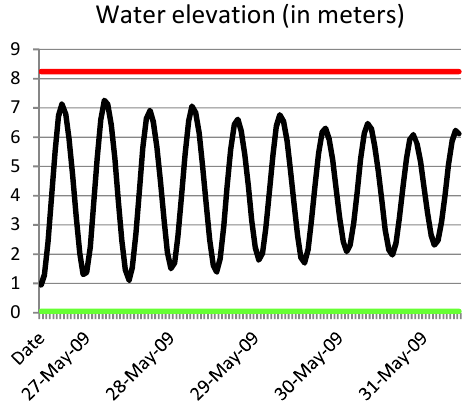
Figure 3: Water elevation estimation in meters at Lanildut harbor between May 27th and 31th of 2009, Highest Astronomical Tide Mark in red, Lowest Astronomical Tide